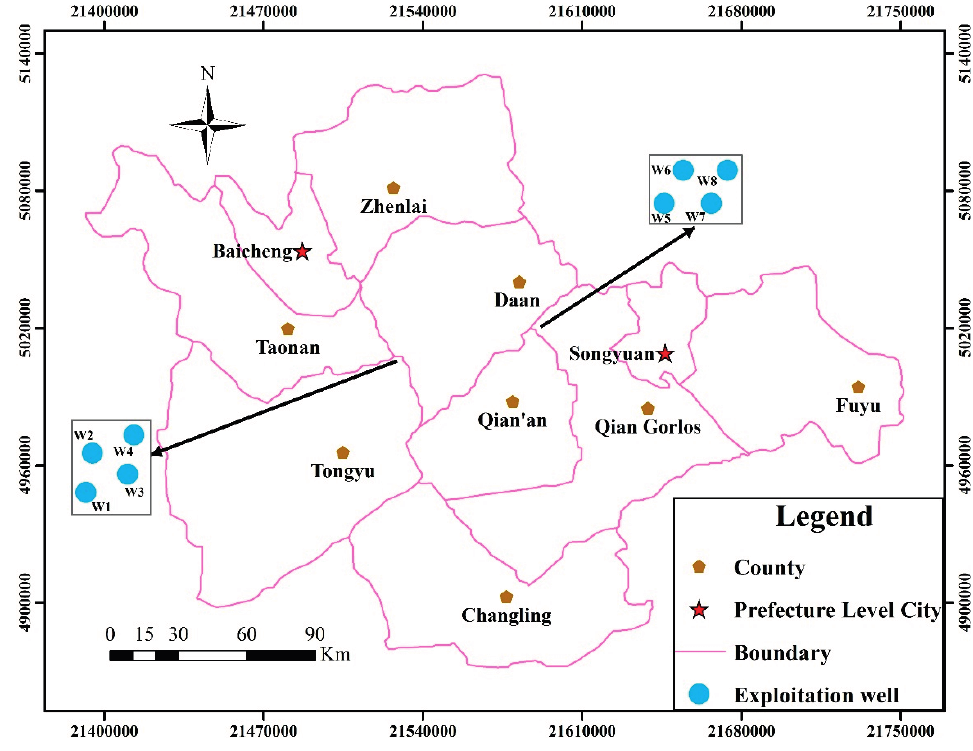
Figure 8. Exploitation wells